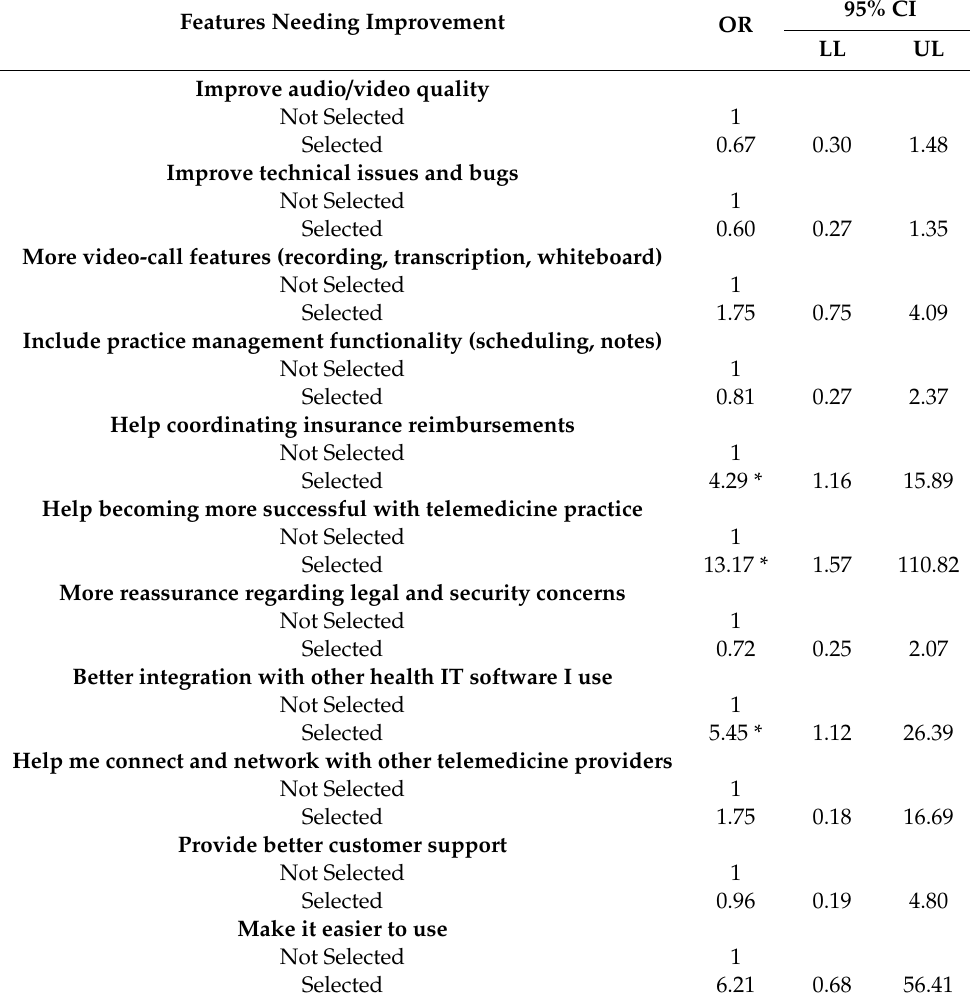
Table 6. Regression of telemedicine features that need improvement on intentions for its future